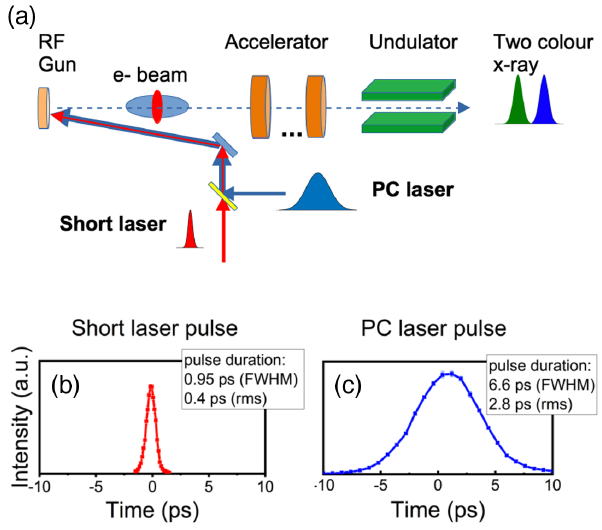
FIG. 1. (a) Proposed two-color FEL scheme. A ps long deep- UV laser is overlapped to the nominal PC laser spoiling locally the emittance. The emittance increase is preserved through the accelerator and in the undulator producing two-color FEL corresponding to the low emittance portion of the beam. Optical cross-correlation traces for (b) emittance spoiler and (c) nominal photocathode